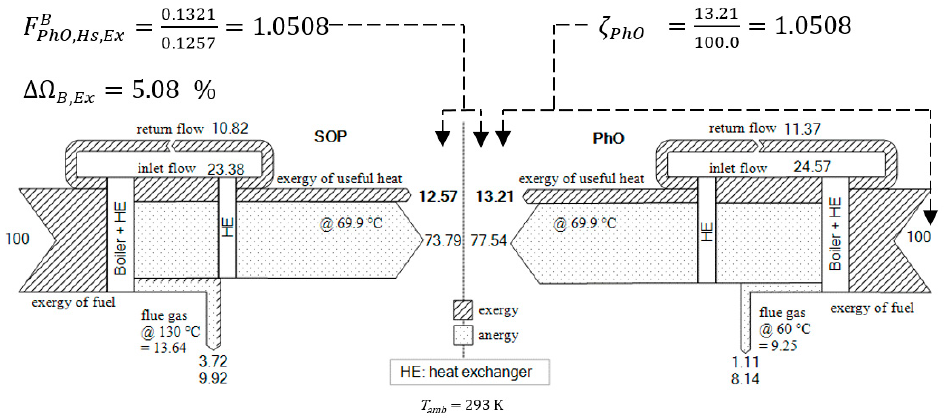
Figure 7. Exergy balance for boiler, real process vs. PhO .